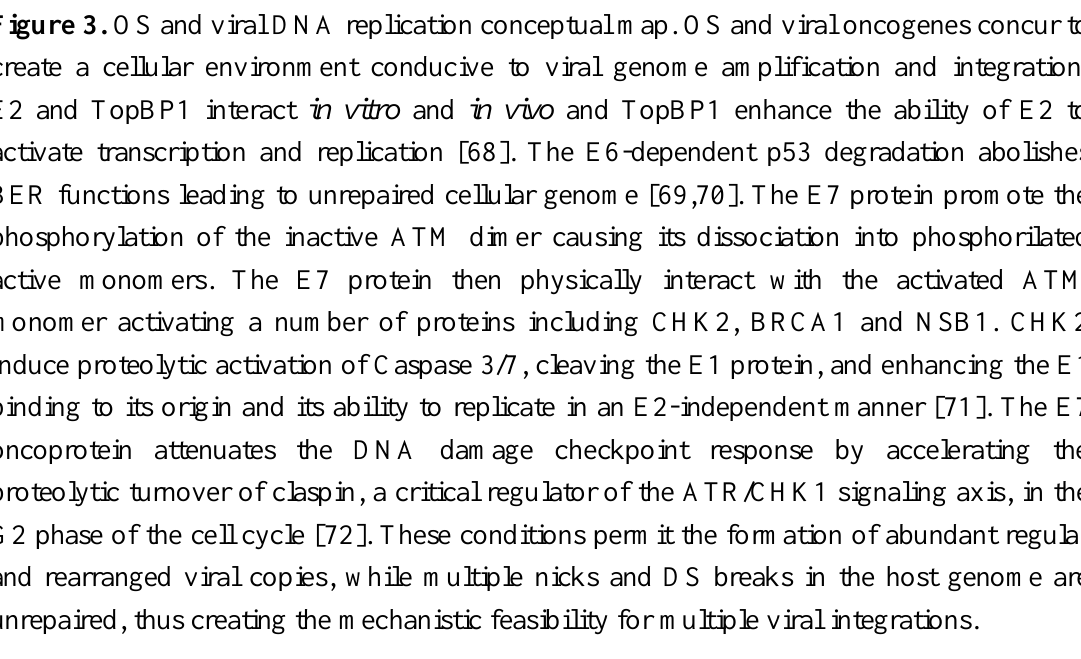
Figure 3. OS and viral DNA replication conceptual map. OS and viral oncogenes concur to create a cellular environment conducive to viral genome amplification and